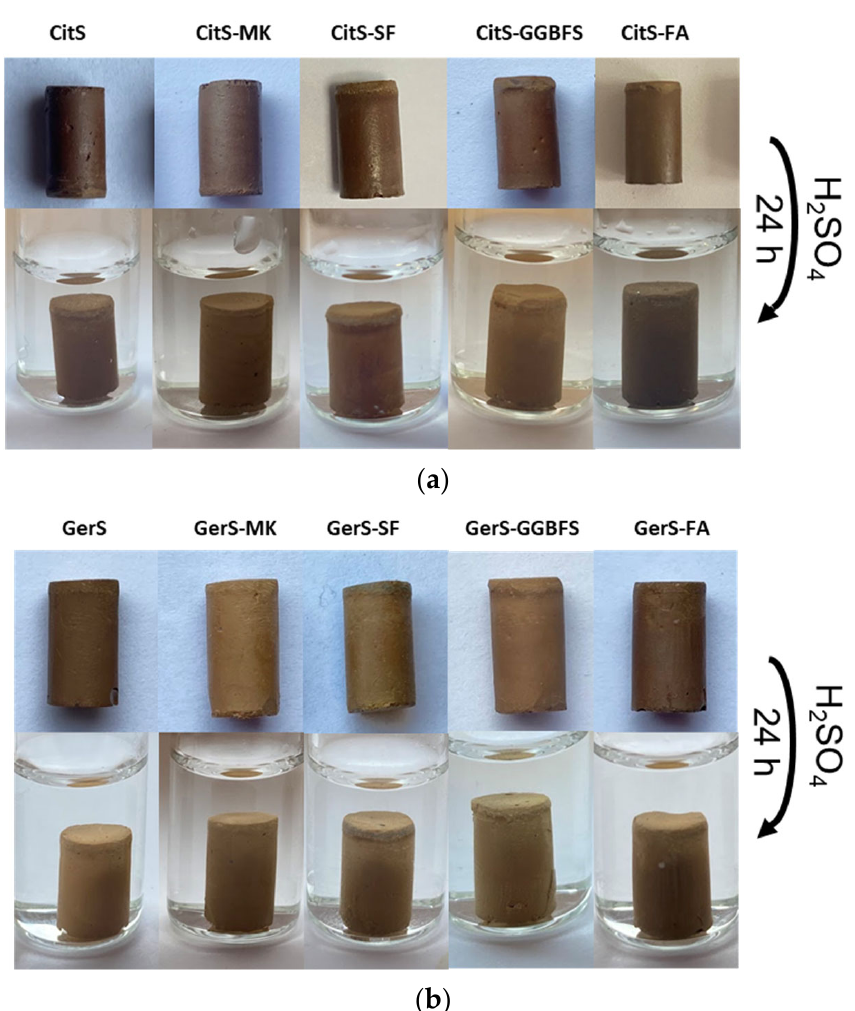
Figure 1 . Representative photos of compressional cylinders of CitS ‐ derived ( a ) and GerS ‐ derived composites ( b ) before (upper row in each image) and after (lower row in each image) acid chal ‐ lenge.